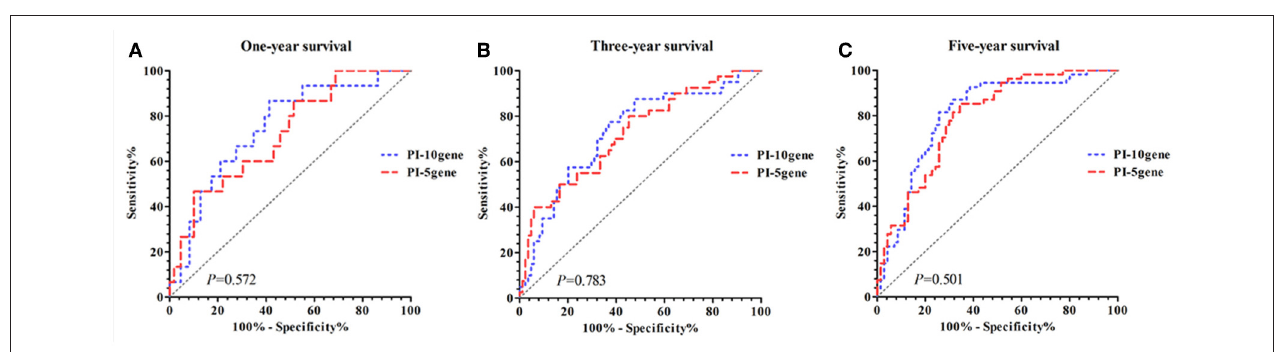
FIGURE 2 | Comparison of predictive performance for PI-10 and PI-5. (A) PI-10 vs. PI-5 (1-year survival). (B) PI-10 vs. PI-5 (3-year survival). (C) PI-10 vs. PI-5 (5-year survival).